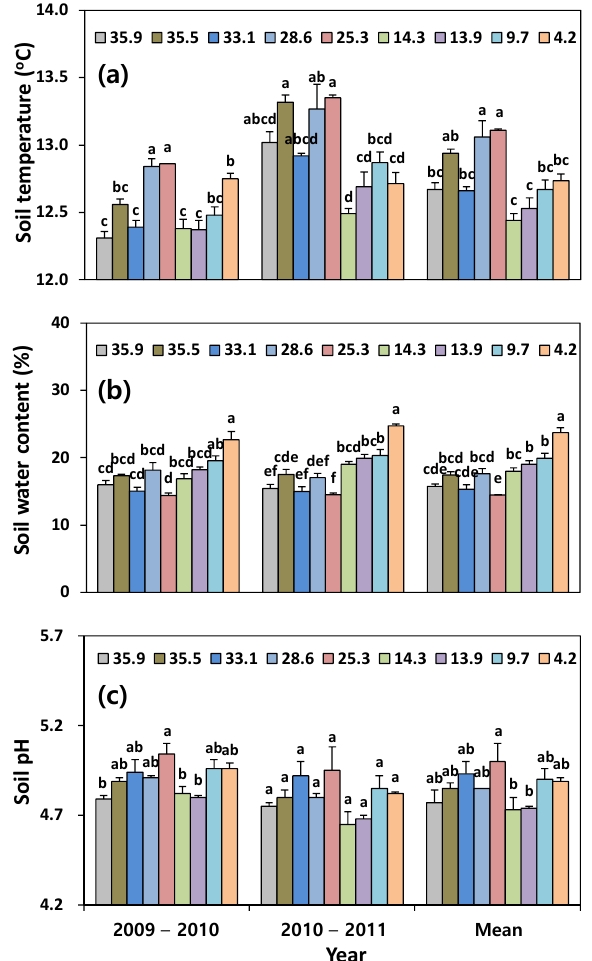
Figure 6. ( a ) Annual mean soil temperature, ( b ) soil water content, and ( c ) soil pH among basal area treatments in pine wilt disease disturbed stands ( n = 3). The different letters among the basal area treatments for each year indicate significance at p < 0.05. The same color across the years denotes the same basal area treatment (disturbance intensity). Vertical bars represent standard error.